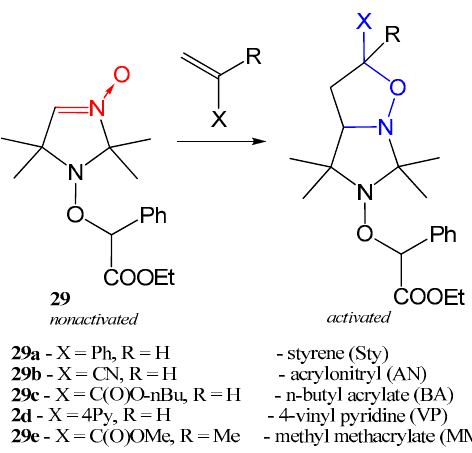
Figure 14. The reaction of 1,3-dipolar cycloaddition of olefin that takes place simultaneously during the initiation of nitroxide-mediated polymerization (NMP).